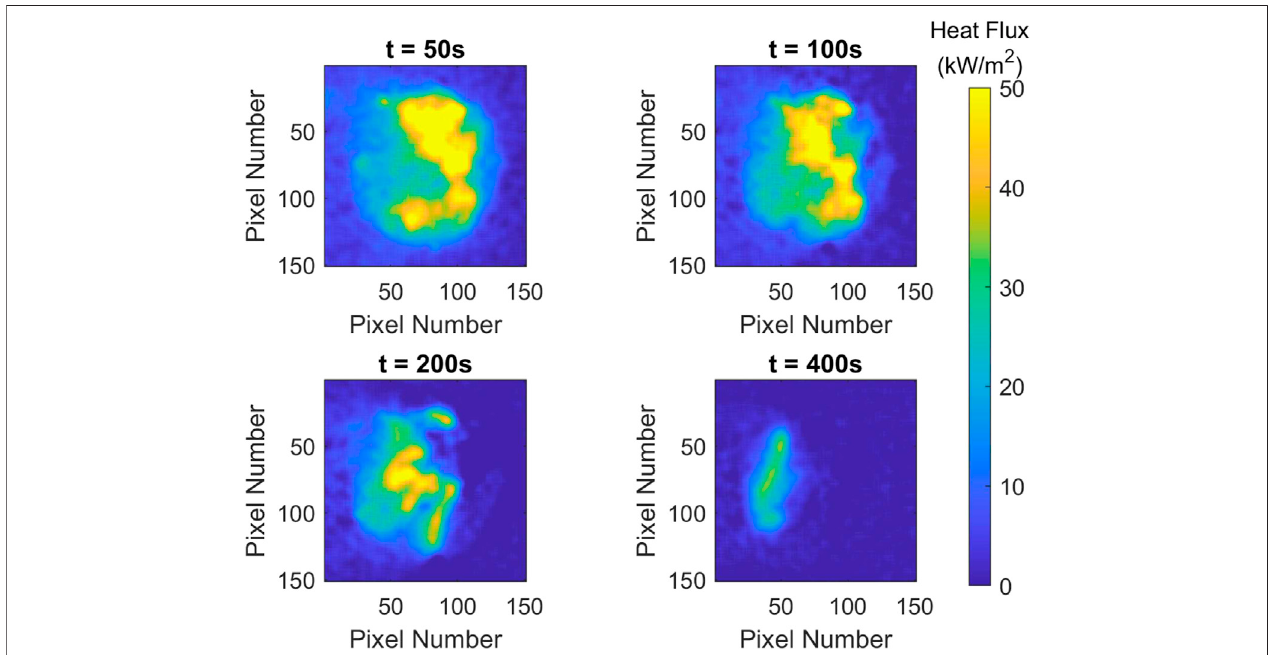
FIGURE 15 | Heat fl ux distribution for test FF16 at different times. Firebrands: D (cid:2) 9.5 mm, L (cid:2) 50.0 mm, and AR (cid:2) 5.3; Pile mass of m (cid:2) 3.0 g; Wind speed: U (cid:2) 2.0 m/s.